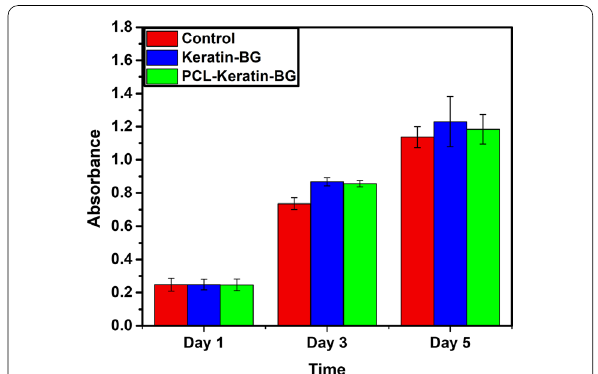
Fig. 8 In vitro cytotoxicity evaluation of cells in contact with scaffold materials for 1, 3, and 5